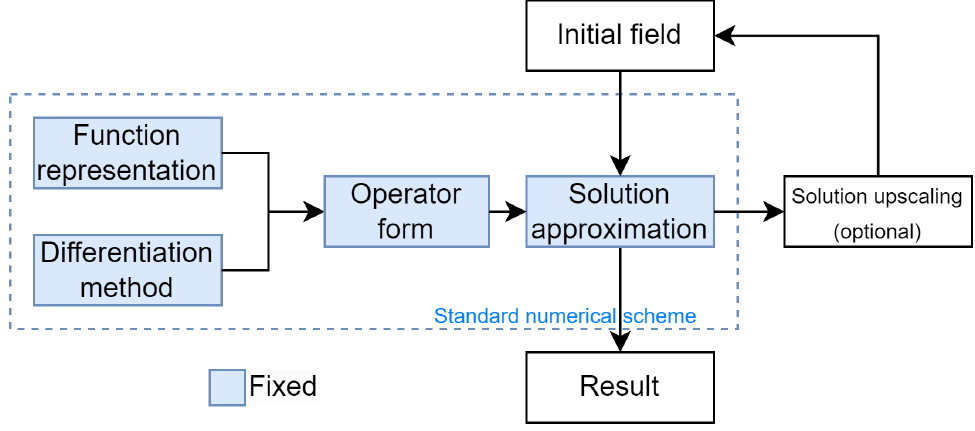
Figure 2. General numerical method for solving differential equations using numerical